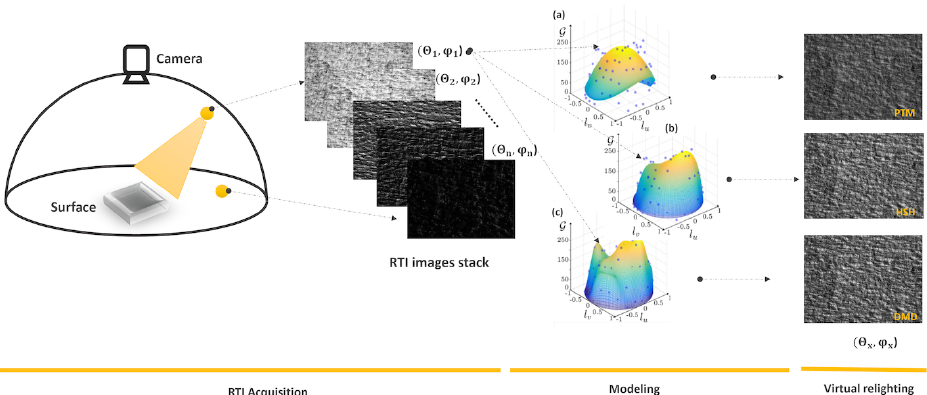
Figure 1. Principle of the RTI technique from acquisition to relighting. The RTI acquisition is the system that allows acquisition of a surface to be made. ( a – c ) Modeling is using the acquisitions to model the behavior per pixel. Visual relighting allows to reconstruct from the models an image lighted with a specific light